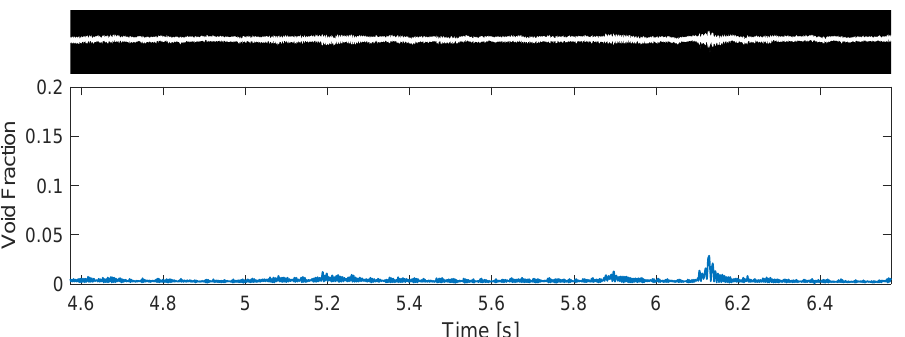
Figure 14. Gas–liquid distribution ( top ) and volumetric fraction of air ( bottom ) of a stable column reconstructed based on camera recordings for a water flow rate of 150 L/min and an air flow rate of 20 Ln/min. The two images correspond to the same data and share the same time axis. Gas is represented in white and liquid in black in the